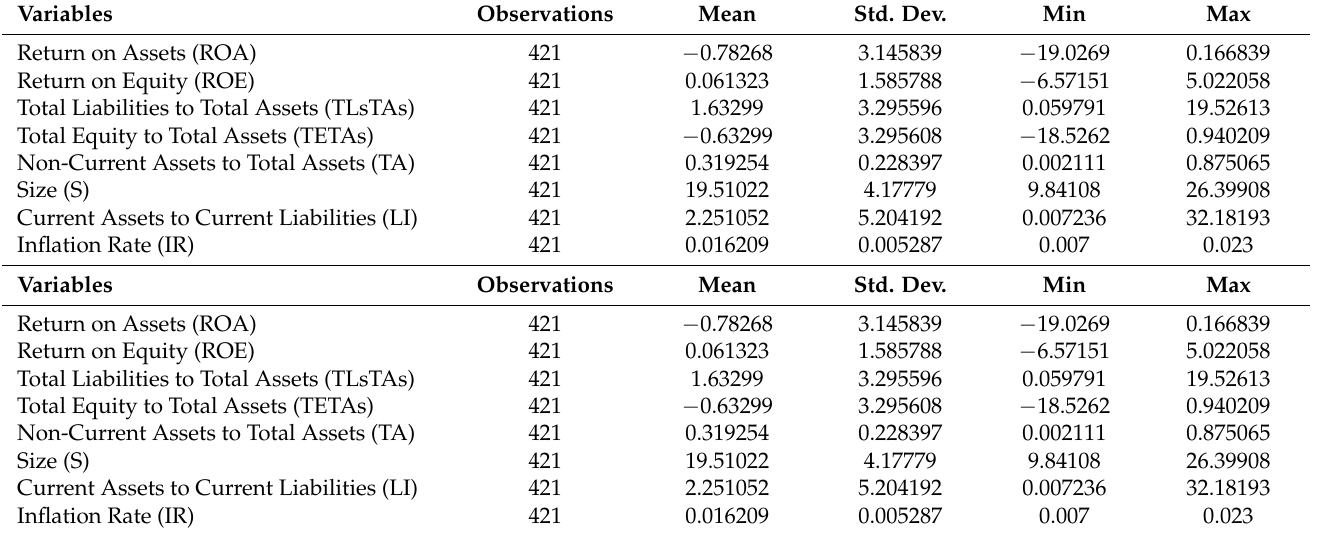
Table 1. Descriptive Statistics of the